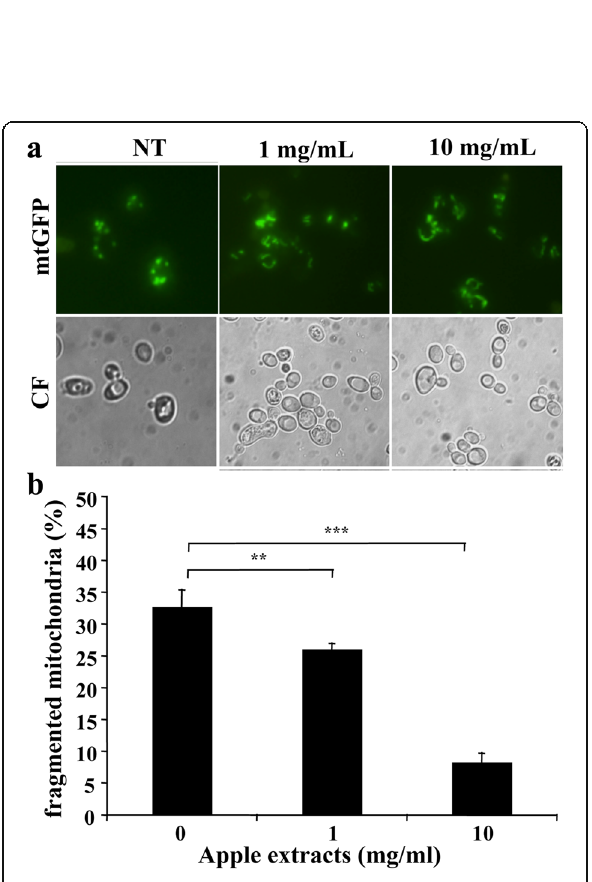
Fig. 5 a The Kllsm4 Δ 1 S. cerevisiae strain was transformed with mito-GFP, which targets GFP into the mitochondrial matrix. Cells were grown in glucose ( SD ) in the absence (NT) and in the presence of apple extracts at the indicated concentrations. The mitochondria morphology was evaluated by analyzing the GFP with an Axioskop2 fluorescence microscope (Carl Zeiss, Jena, Germany) equipped with a digital camera (micro-charge-coupled device). b Quantification of cell population showing fragmented mitochondria. Data represent the mean of three independent experiments. p -value: **<0.01; ***